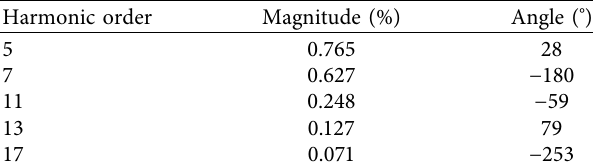
Table 2: Te detailed information of fve harmonic